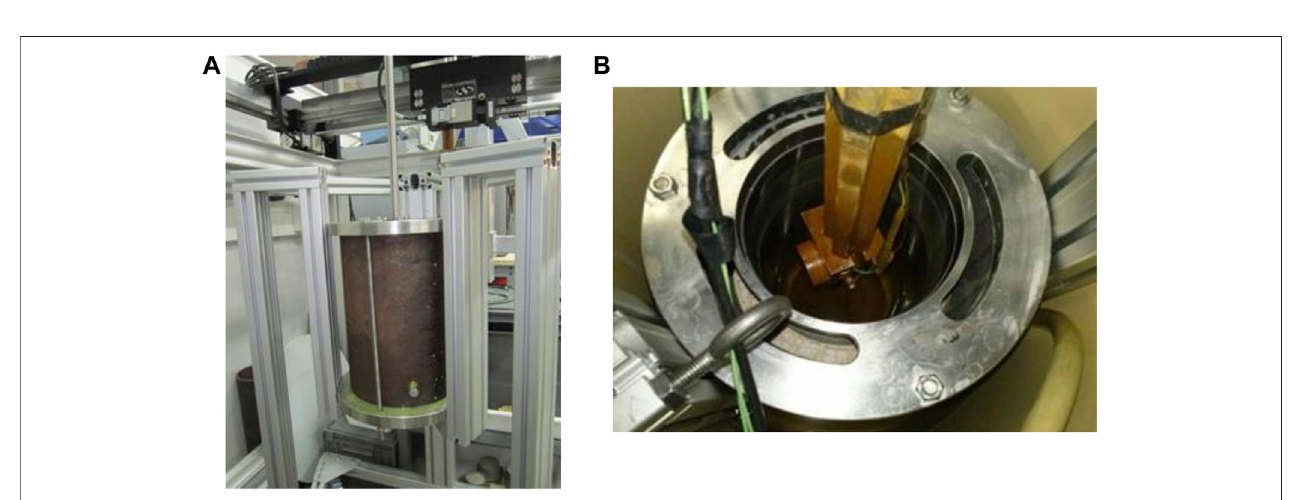
FIGURE 5 | Lab scale simulated cemented annulus unit and acoustic logging apparatus. (A) is the side view. (B) is the side view. After (Thomas J. et al., 2014).